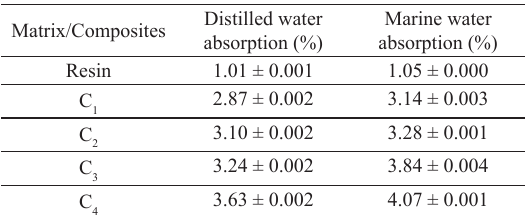
Table 5. Results of the distilled and marine water absorption tests for the composites and the polyester resin. Matrix/Composites